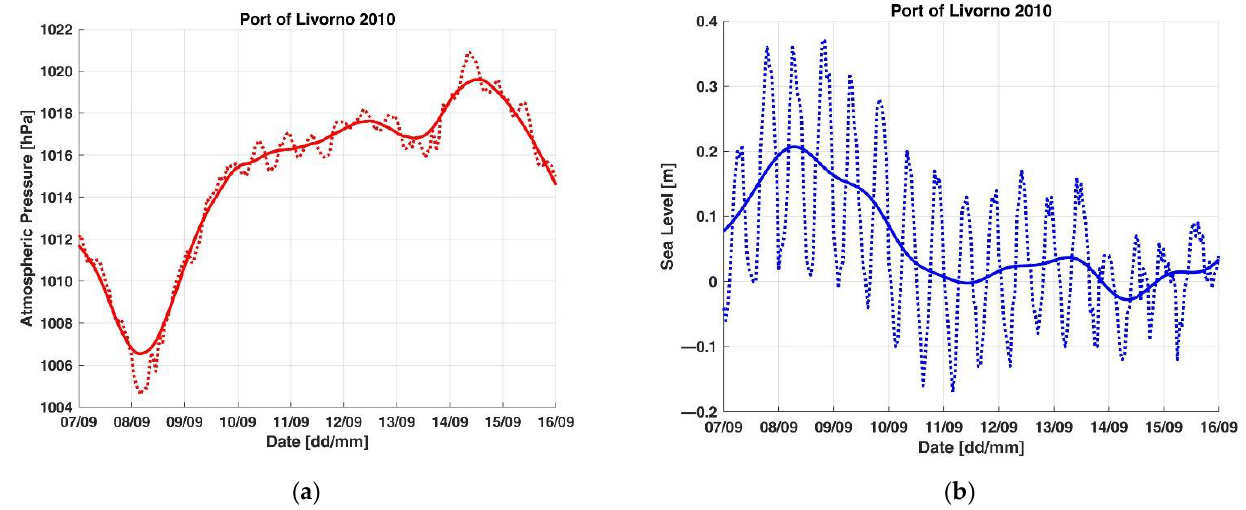
Figure A1. Low-frequency components of meteo-mareographic parameters acquired by ISPRA’s monitoring station in the port of Livorno from 7 to 16 September 2010: ( a ) atmospheric pressure; ( b ) sea level.